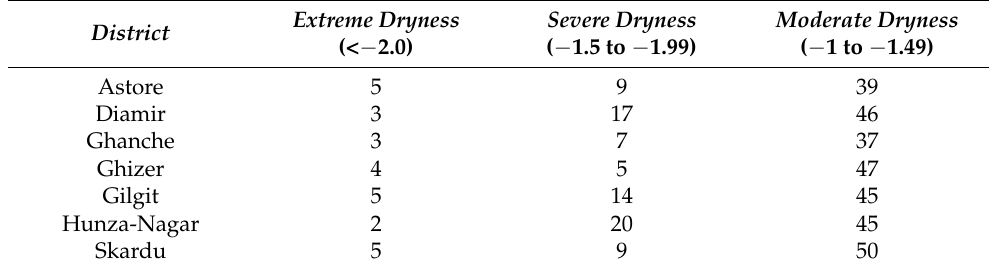
Table 4. Frequency of drought for 1-month